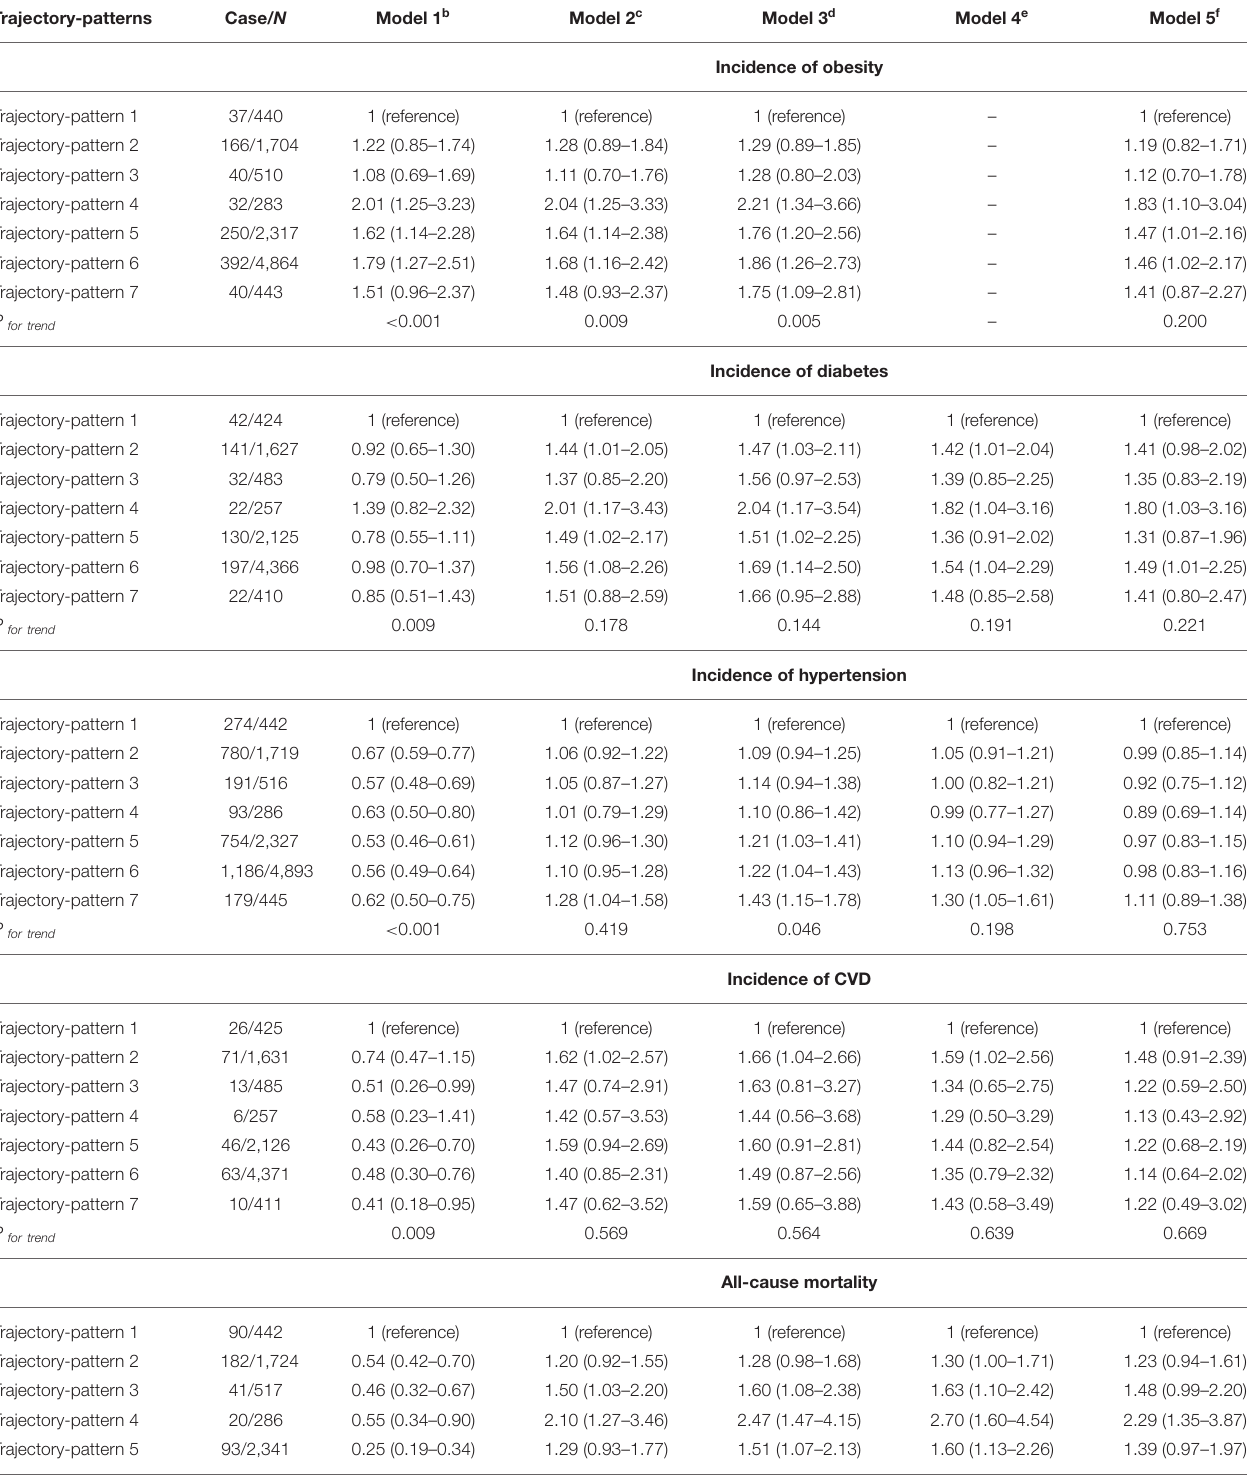
TABLE 2 | Association of trajectory-patterns with risk of cardio-metabolic disease and all-cause mortality a .